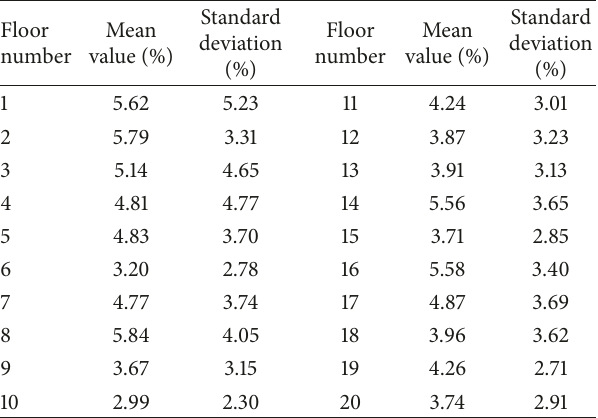
Table 8: The mean value and standard deviation of errors for the estimated wind load with +10% error in damping